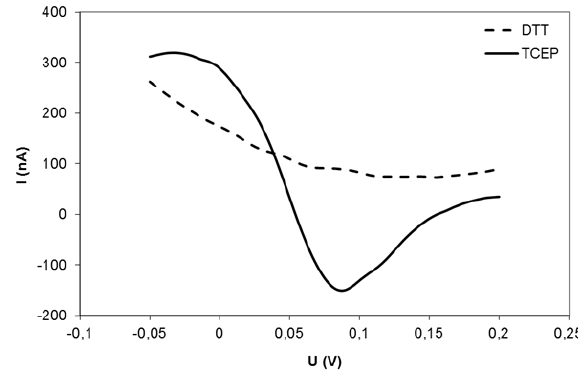
Figure 1: Polarograms of dithiothreitol (DTT) and tris(2-carboxyethyl) phosphine (TCEP)